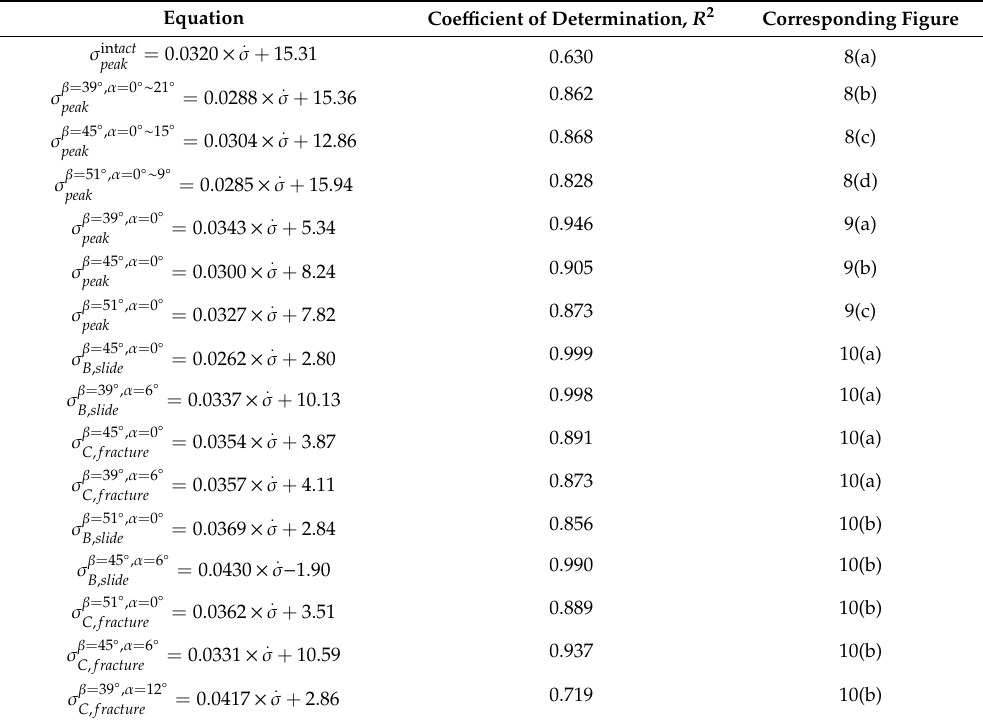
Table 4. Results of linear regression between dynamic peak stress / strength and loading rate. Equation Coe ffi cient of Determination, R 2 Corresponding Figure 0.630